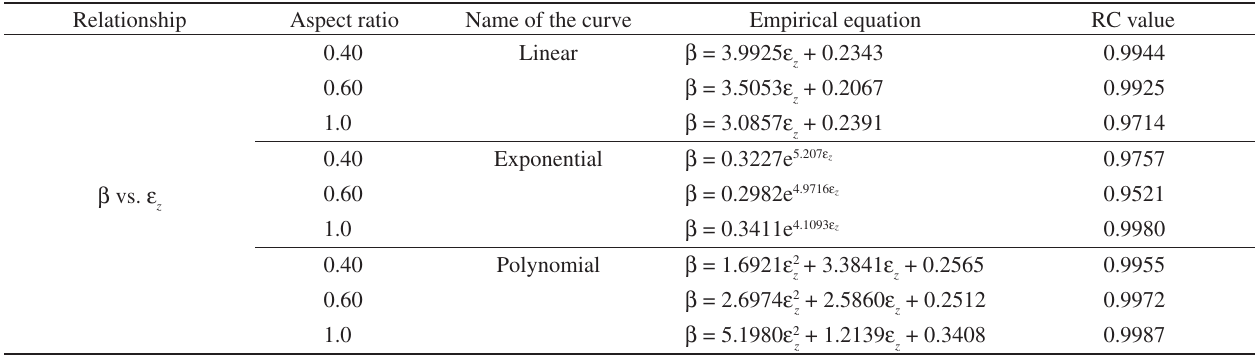
Figure 2. a) Relationship between β and e and d) relationship between β and e Table 1. Curve fitted results between β and e